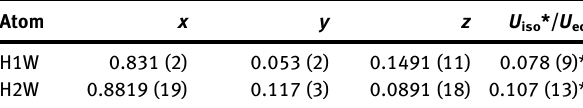
Table  : Fractional atomic coordinates and isotropic or equivalent isotropic displacement parameters (Å 